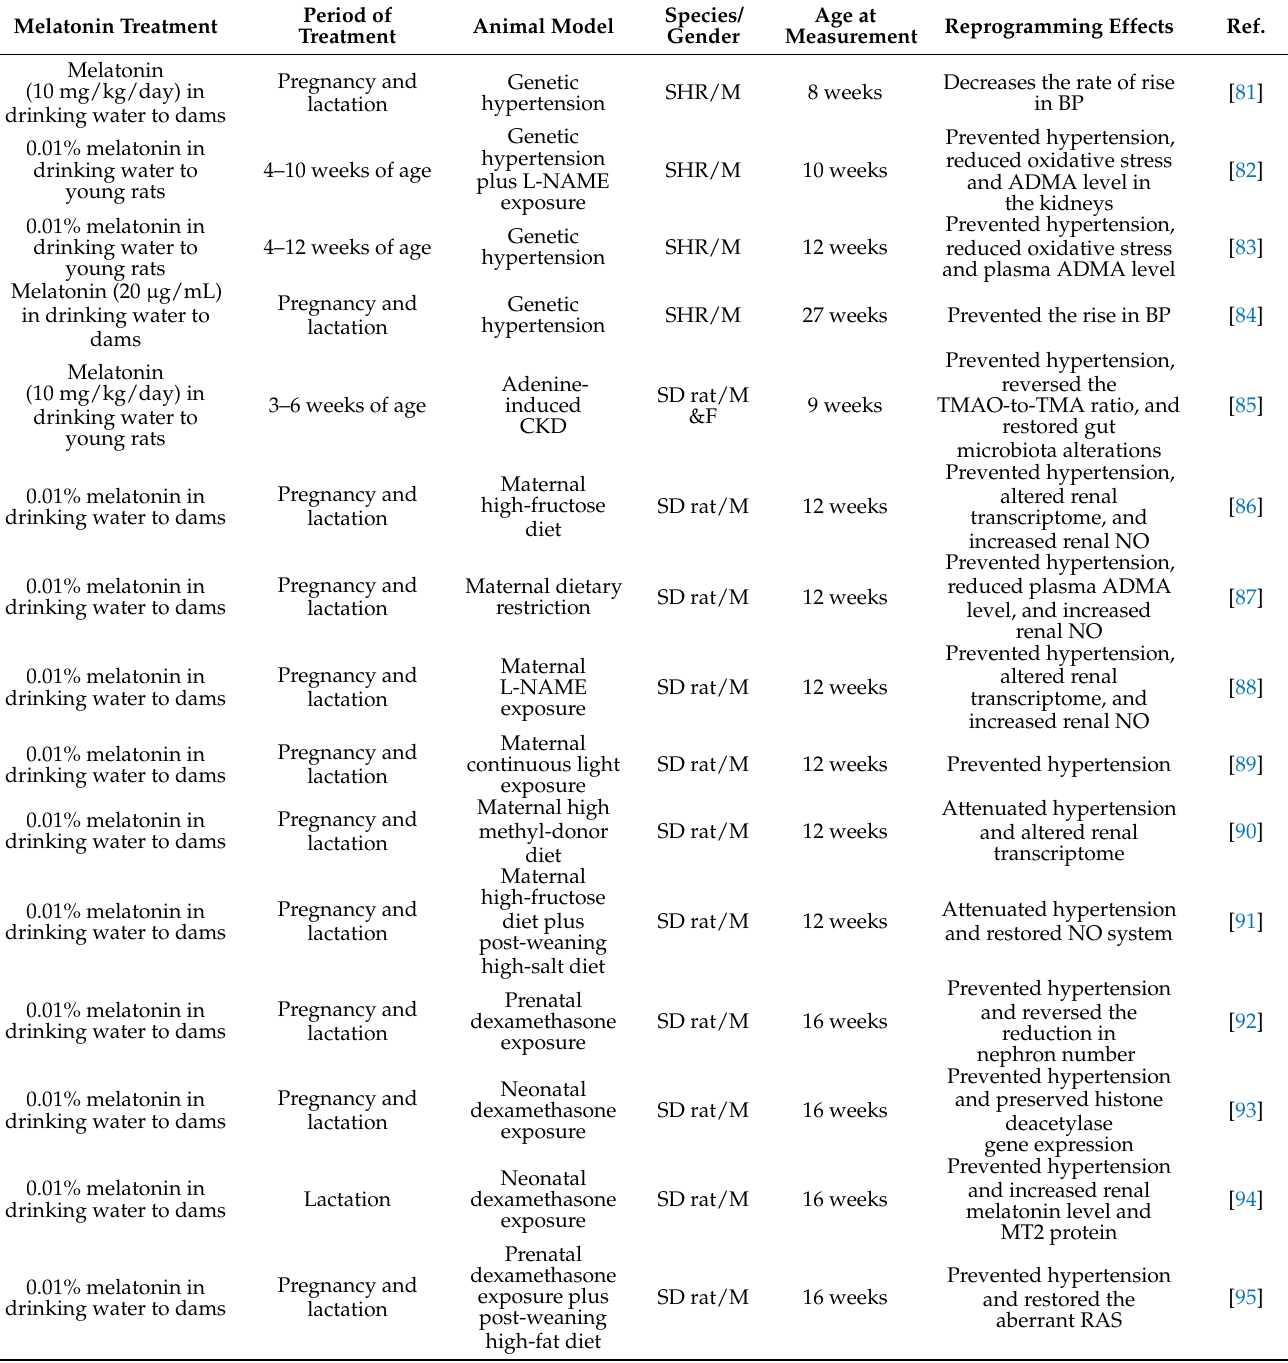
Table 1. Reprogramming effects of melatonin protect against early origins of hypertension in animal